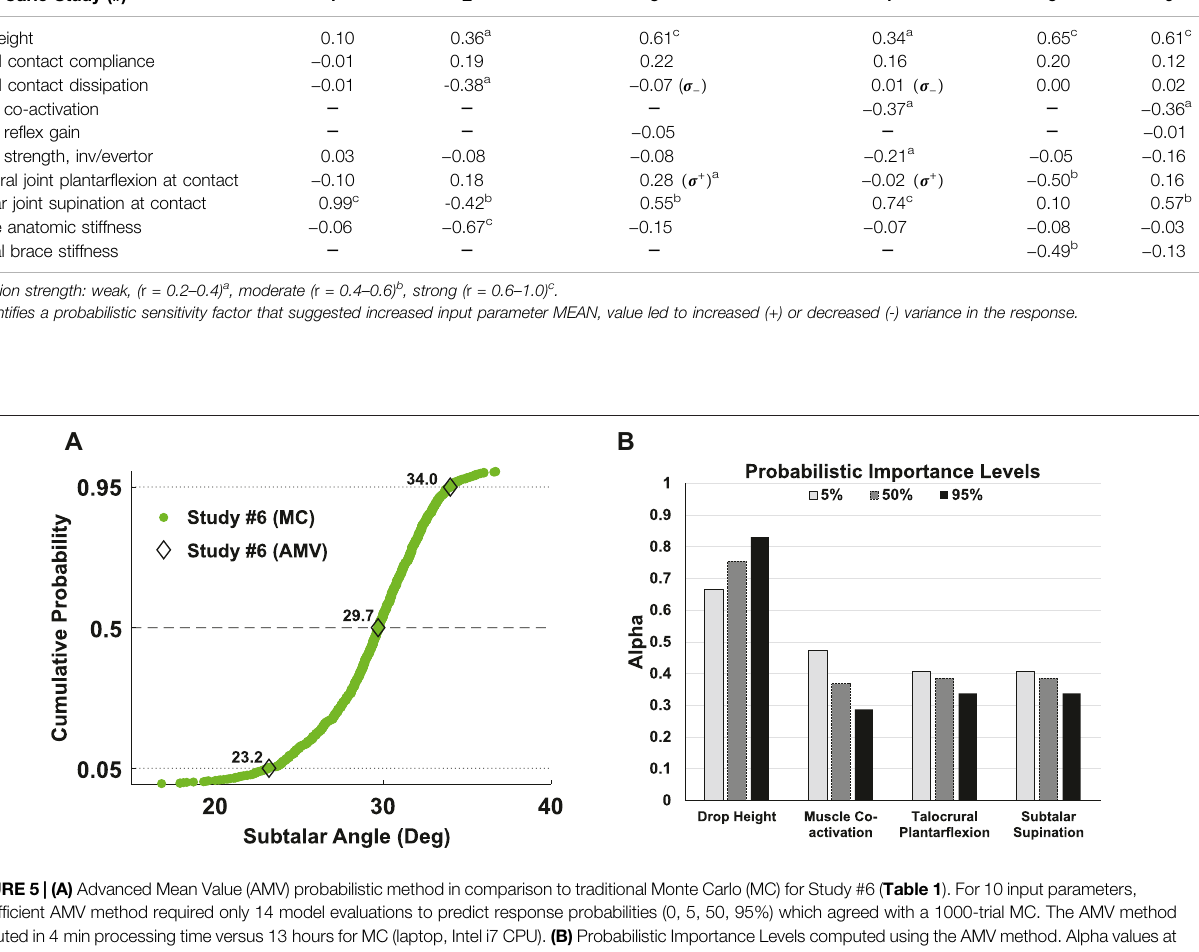
Frontiers in Bioengineering and Biotechnology |